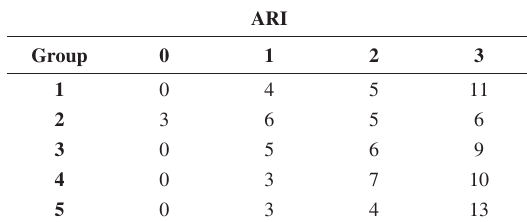
Table 2. Adhesive Remnant Index (ARI) scores for the evaluated groups.